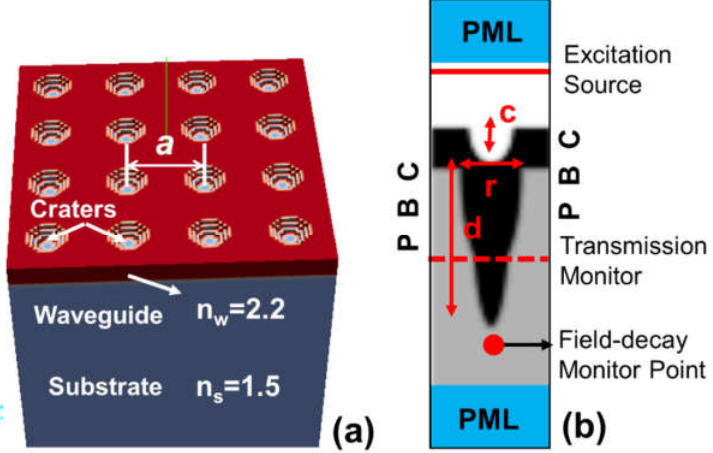
Figure 2. Numerical simulation models. ( a ) A 3D-FDTD model of the FS laser-generated nano-holes after deposition of the waveguide layer. The formation of craters on the surface, lattice constant a , and refractive indices of substrate and waveguide are indicated. ( b ) Unit cell simulation model with an indication of boundary conditions, the position of the source, transmission monitor, and field decay monitor point. The depth of nano-hole d , its surface radius r , and the depth of the crater c are notified.